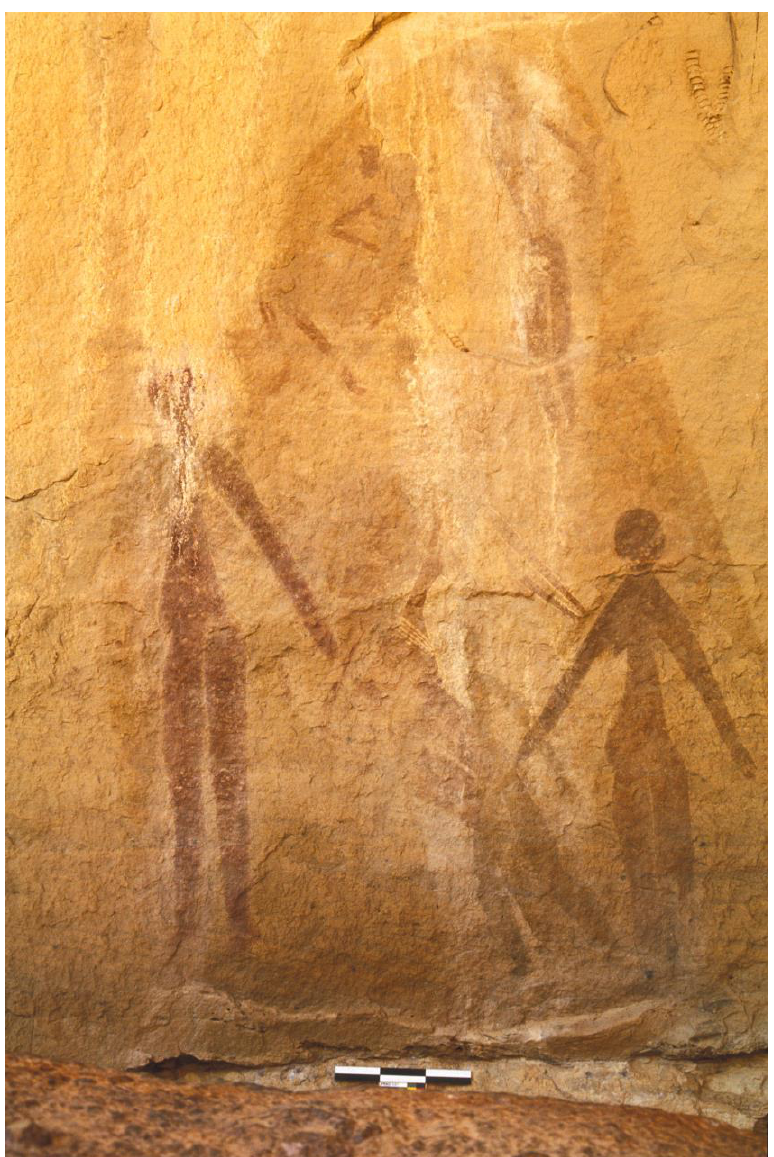
Figure 4. Round Heads red paintings, from T-Anshal-t